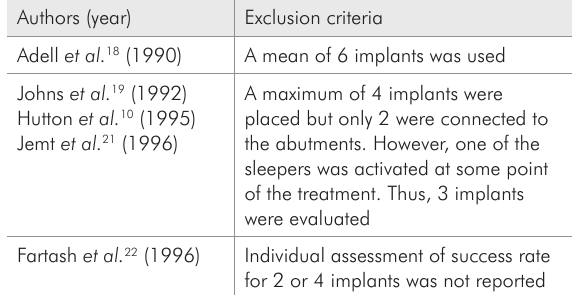
table 3 - Studies excluded and reason why. table 4 - Characteristics and scores used for quality analy- sis of selected